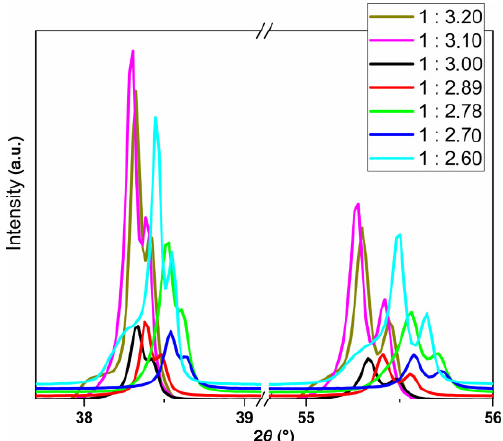
Fig. 3 hkl peak = 200 (diffraction between 38° and 39°) and hkl peak = 220 (diffraction between 55° and 56°) with peak shift of different powder compositions (Cu Kα, λ = 1.54056 Å).